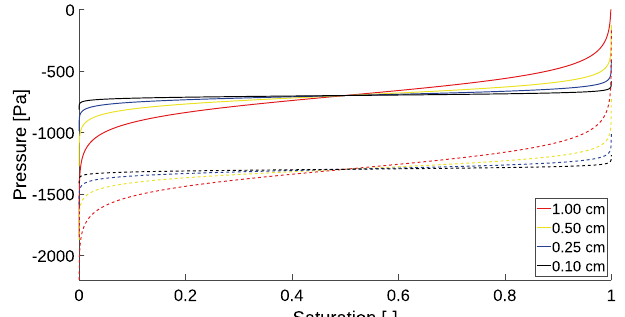
Figure 3. Scaling of the retention curve with the block size (cid:31) x . Grid block sizes are colour-coded. The solid line denotes the main wetting branch and the dashed line denotes the main draining